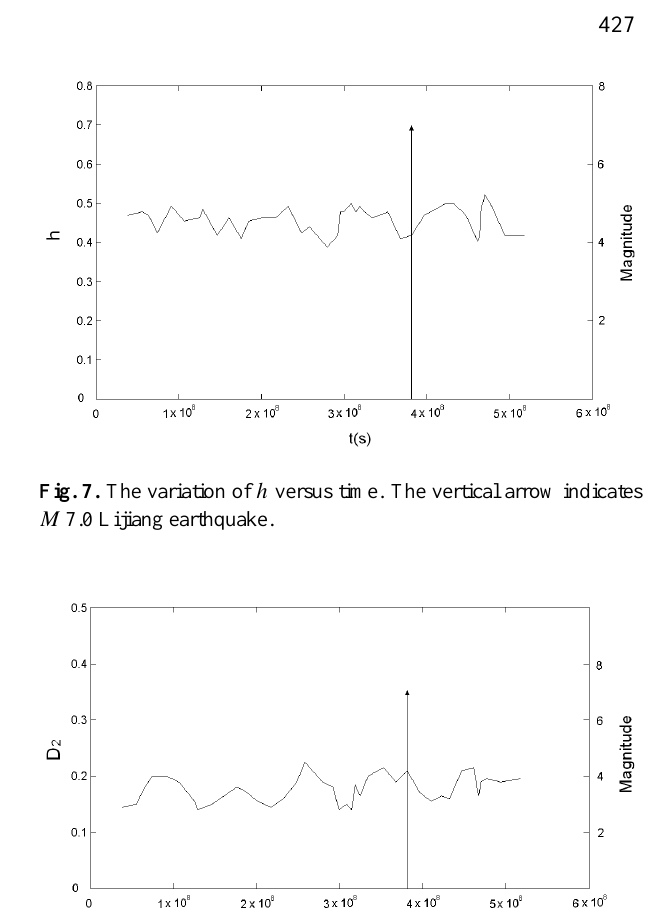
Fig. 8. The variation of correlation dimension D 2 versus time. The vertical arrow indicates M 7.0 Lijiang